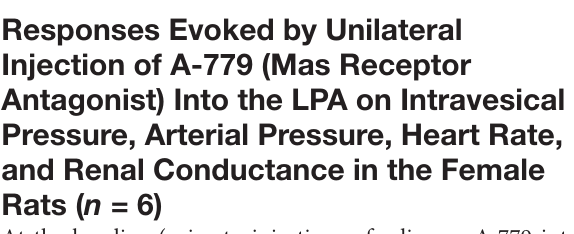
( − 2.95 ± 5.32%), and IP (0.65 ± 6.41%) compared with